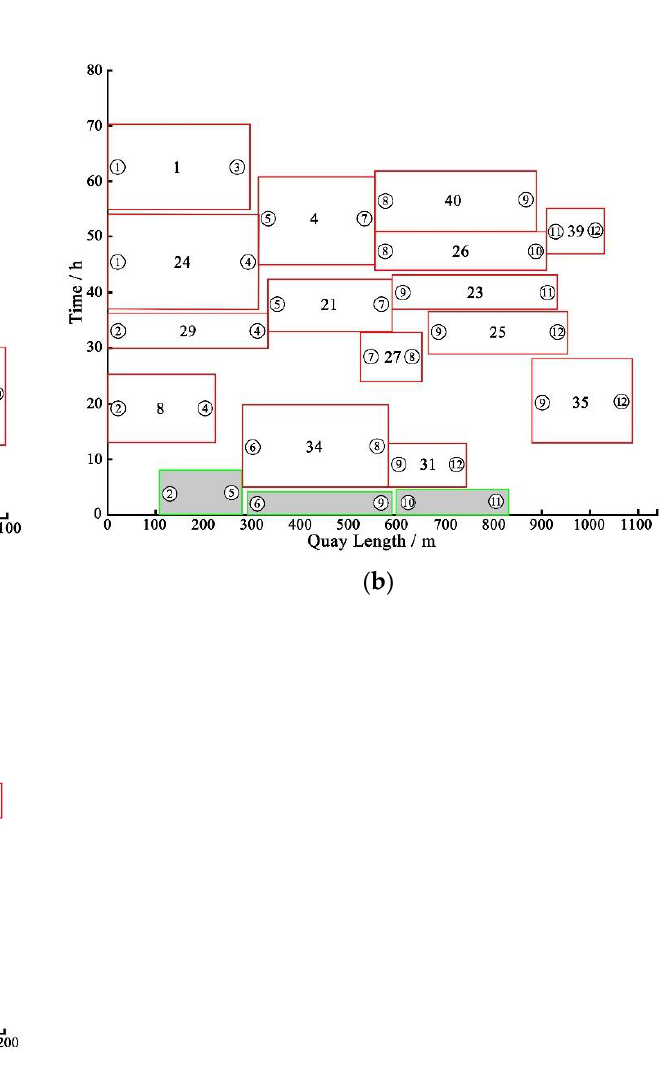
Figure 9. The scheduling solution under M + C. ( a ) terminal 1; ( b ) terminal 2; ( c ) terminal 3. (Source: compiled by authors).